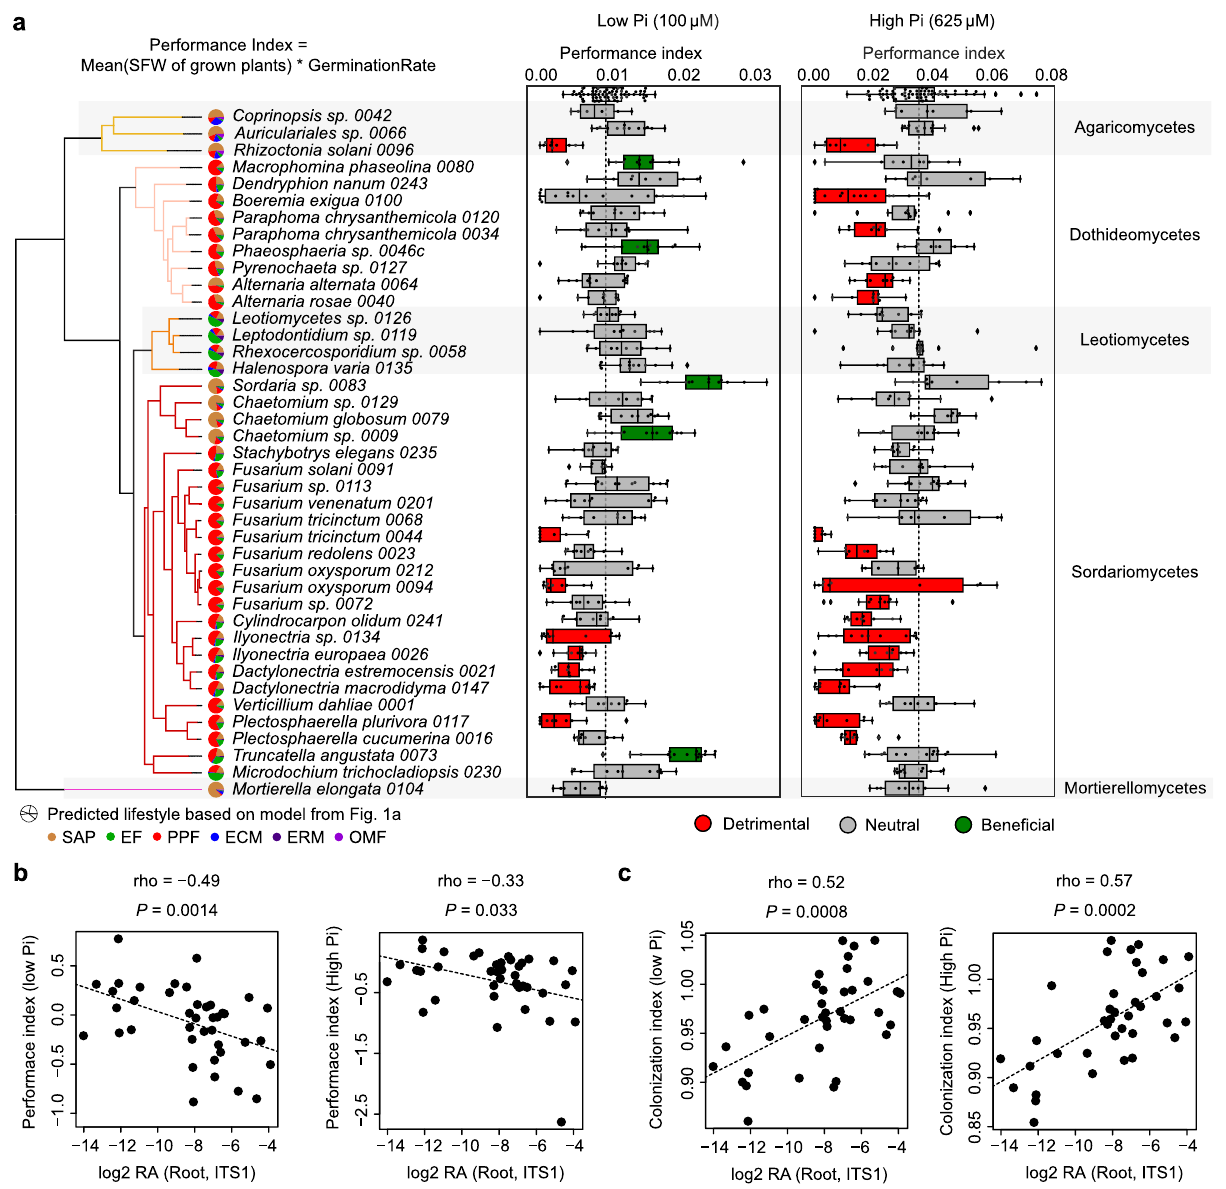
Fig. 4 Linking fungal outcome on host performance with root colonization patterns. a Performance indices (shoot fresh weights of 4-week-old plants normalized by germination rate) of A. thaliana plants recolonized with each of the 41 fungal strains on media containing low and high concentrations of orthophosphate (Pi). At least three independent biological replicates resulting in 2 – 4 values each were performed for each fungus ( n = 6 – 18). Boxes are delimited by fi rst and third quartiles, central bars show median values, whiskers extend to show the rest of the distribution, but without covering outlier data points (further than 1.5 interquartile range from the quartiles, and marked by lozenges). Differential fungal effects on plant performance were tested on both media with Kruskal – Wallis (at high and low Pi: P < 2.2e − 16) and bene fi cial and pathogenic strains were identi fi ed by a two-sided Dunn test against mock-treated plants ( fi rst row in boxplots). Vertical dash lines indicate the mean performance of mock-treated plants. Left to the boxplots is displayed the strain phylogeny, together with lifestyle probabilities predicted by the Random Forest classi fi er trained for ancestral lifestyle prediction in Fig. 2a. b Spearman ’ s rank correlation of relative fungal abundances in root samples from natural populations (log2 RA, see Fig. 1a, 18 ) with fungal effects on plant performance at low Pi (left) and high Pi (right) (Hedges standard effect sizes standardizing all phenotypes to the ones of mock-treated plants). c Spearman rank correlation of relative fungal abundances in root samples from natural populations (log2 RA, see Fig. 1a, 18 ) with fungal colonization indices measured by quantitative PCR in our plant recolonization experiments at low Pi (left) and high Pi